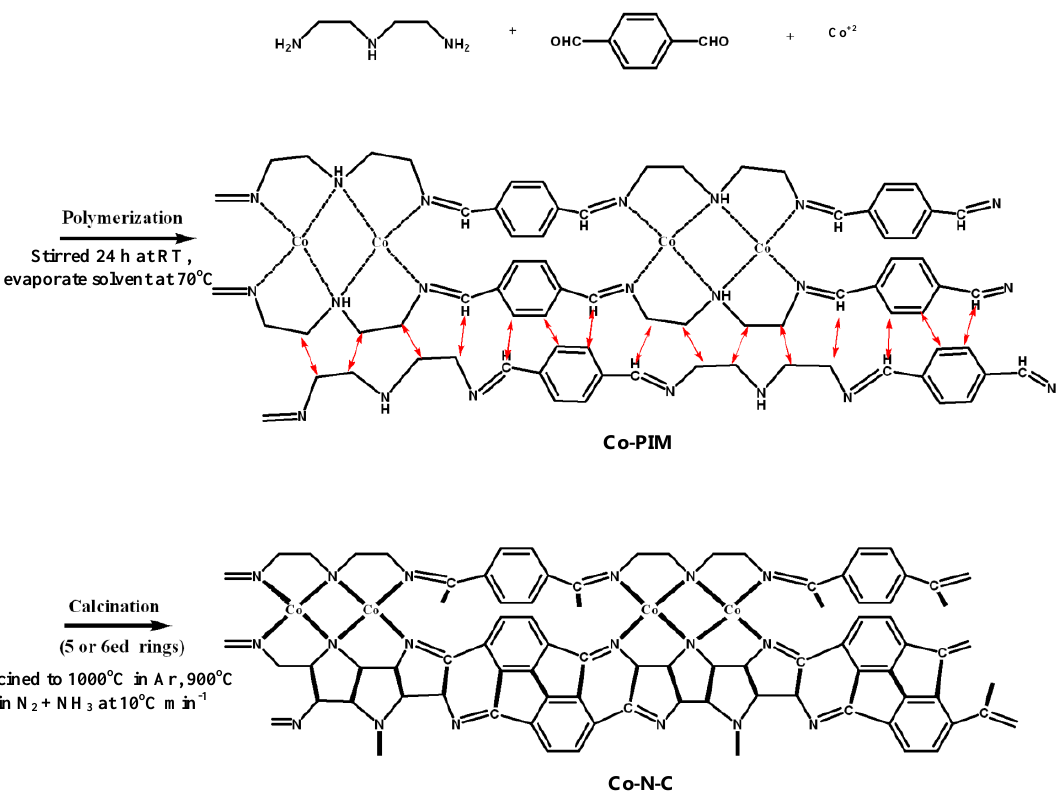
Scheme 1 . Schematic diagram of preparation of Co-PIM and